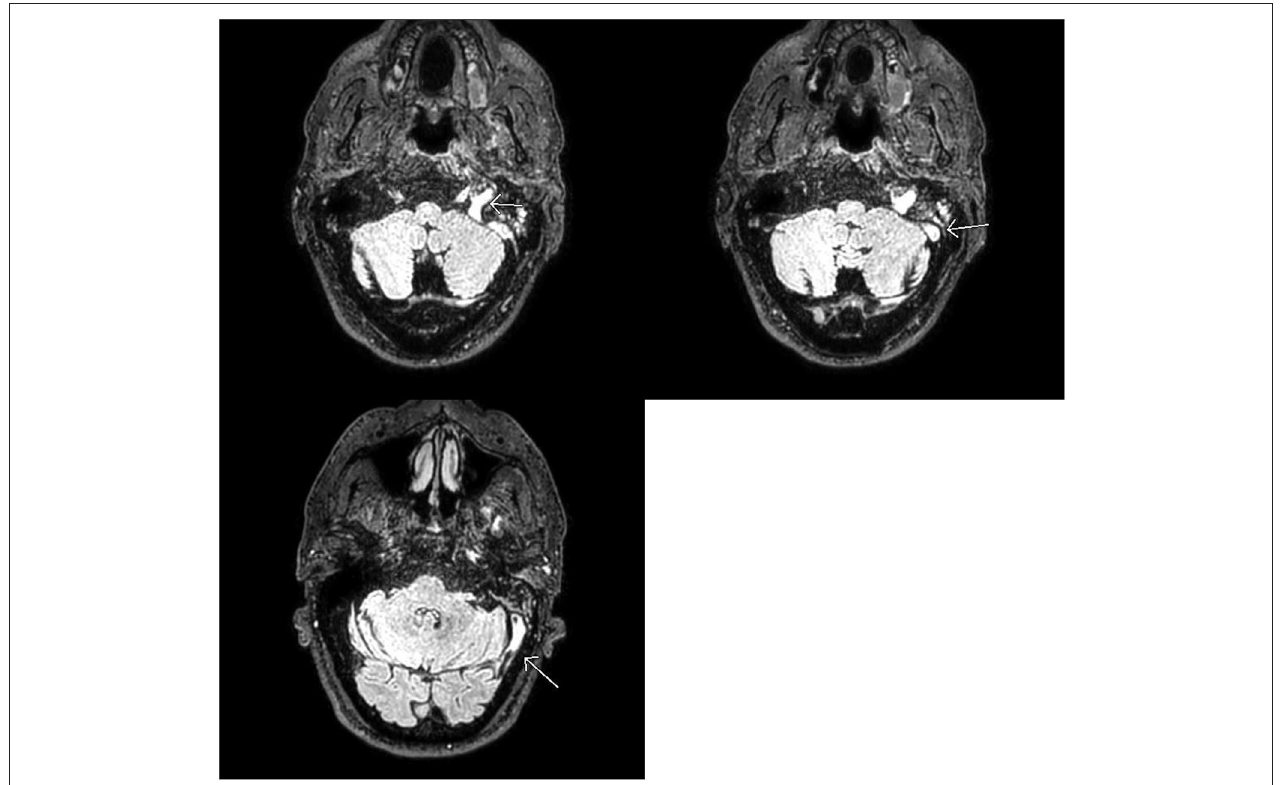
FIGURE 1 | MRI Brain: Abnormal FLAIR signal in the distal left transverse and sigmoid sinuses as well as the jugular bulb with loss of normal flow void. No corresponding signal abnormality on T1 or gradient weighted sequences (not shown). Findings favored to be slow flow but can be seen with dural venous sinus thrombosis in the setting of headaches. If there is clinical concern for dural venous sinus thrombosis, CT, or MR venogram should be considered for definitive